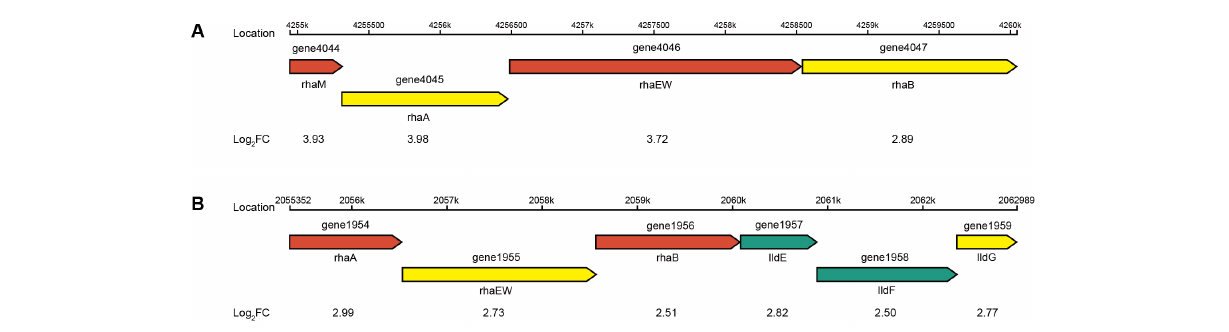
FIGURE 8 The GO enrichment of the SDE genes.